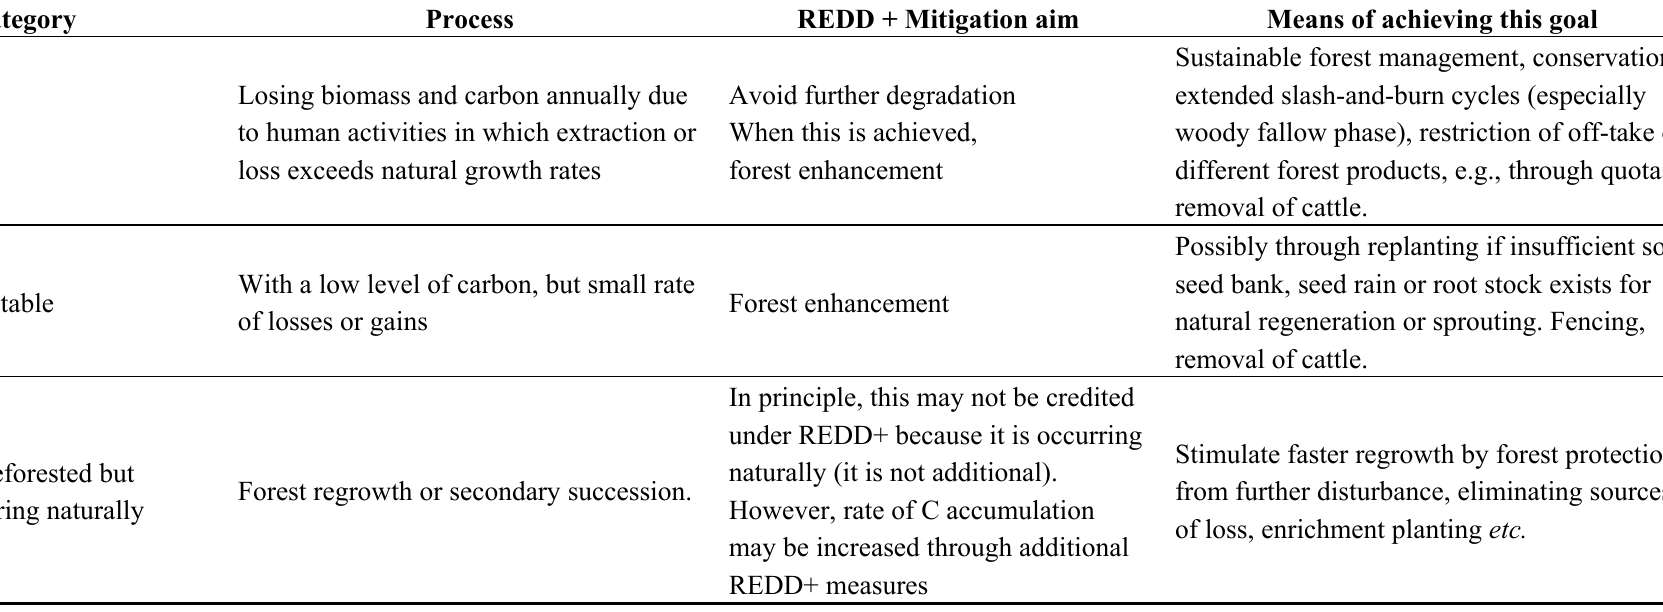
Table 3. Suggested activities under REDD+ appropriate to counter different phases of forest